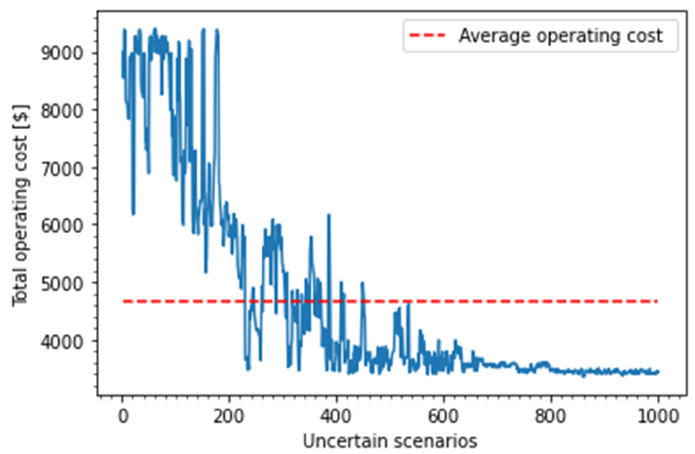
Figure 4. DCM’s operating cost under the DQN ‐ based MPC approach.